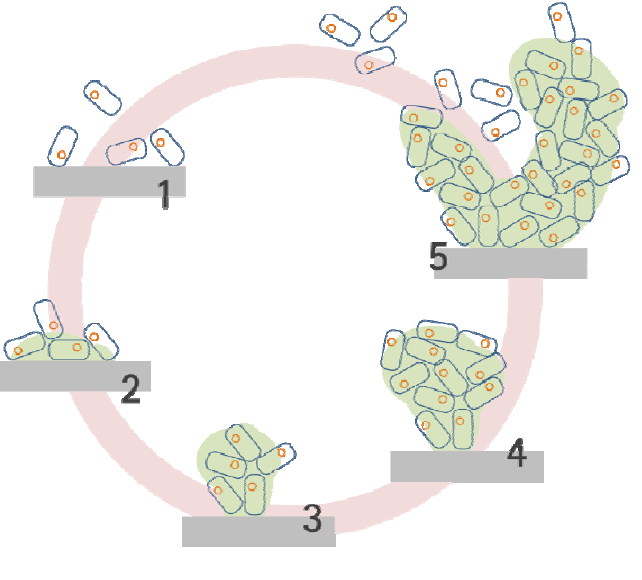
Figure 1. Pseudomonas aeruginosa biofilm development sequence; step 1 initial adhesion of a bacterial cell to a surface; step 2 induce irreversible adhesion by EPS generation; step 3 early structural development; step 4 maturation of the biofilm; step 5 dispersion of cells from the biofilm